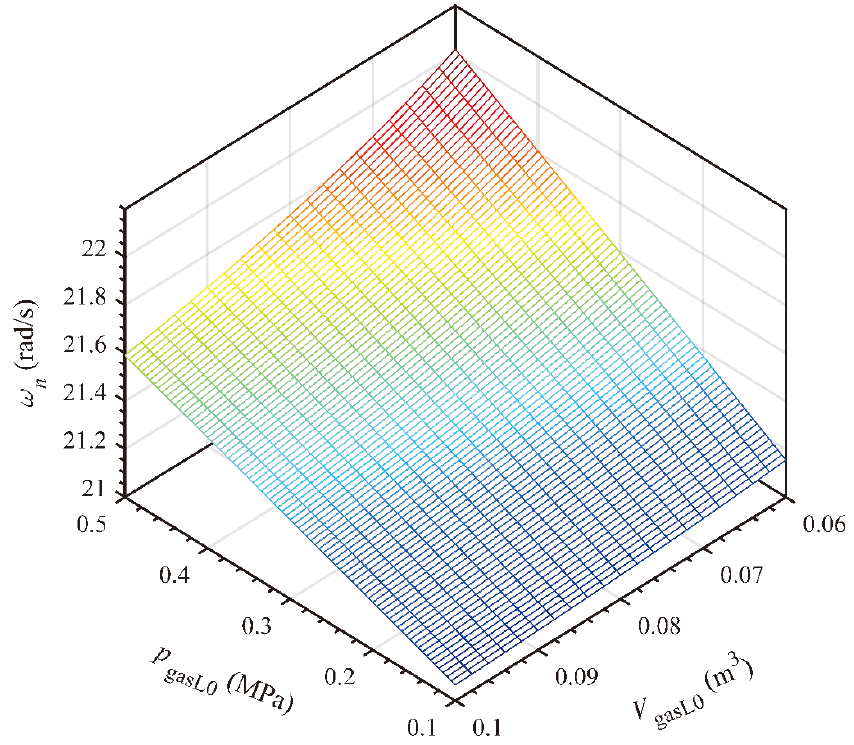
Figure 12. Effects of the pressure and volume of the low-pressure accumulator, p gasL0 and V gasL0 on the natural annular frequency, ω n .